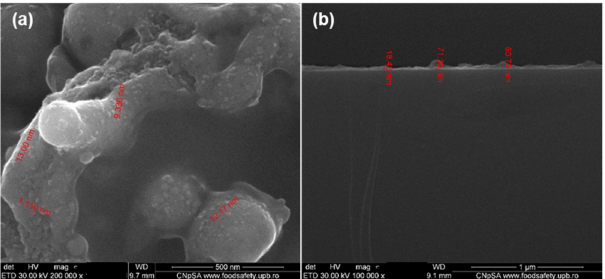
Figure 16. Plain view ( a ) and cross-section ( b ) SEM micrographs of Fe 3 O 4 @ β -CD/PTX deposited at 400 mJ/cm 2